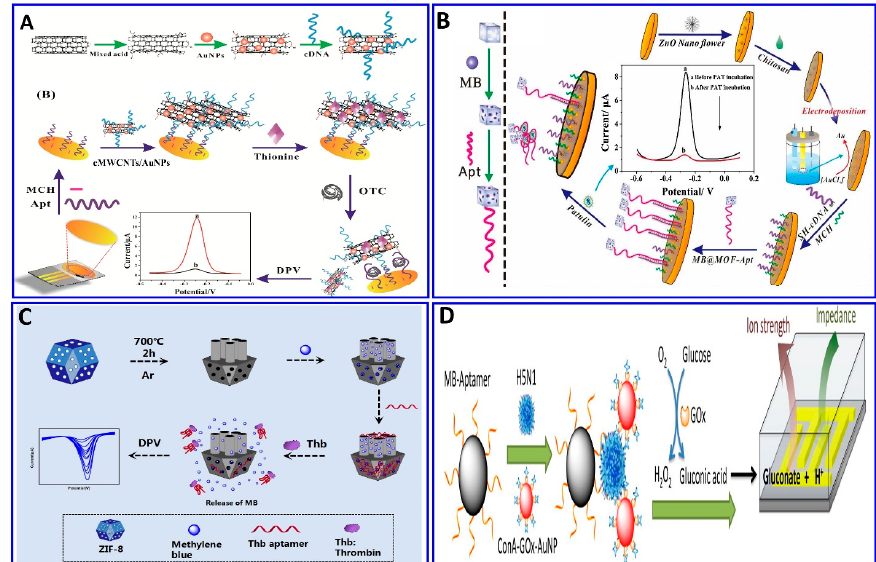
Figure 10. ( A – C ) Schematic protocols for electrochemical aptasensor based on the target-responsive label electroactive dye amplification strategy. ( A ) OTC assay using AuNP/cMWCNT/cDNA@thionine probe as a signaler releasing thionine, re- produced from [196]. ( B ) PAT assay using MOF@Methylene blue signal tags, with signals as a function of PAT concentra- tions, reproduced from [43]. ( C ) Thrombin assay based on target-responsive methylene blue (MB) release from the ZIF-8 surface as a function of the thrombin concentration, reproduced from [13]. ( D ) Schematic protocols for an electrochemical aptasensor based on an enzymatic catalytic reaction, reproduced from [201].